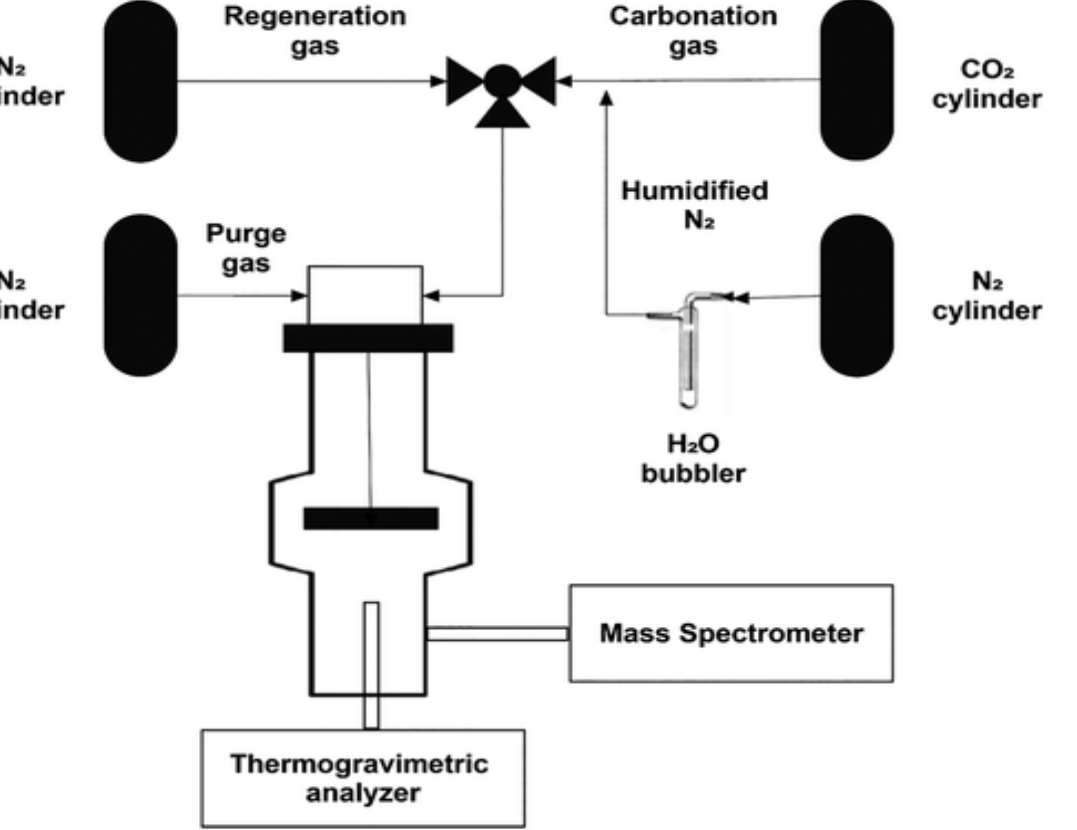
Figure 1. The schematic design of the experimental setup utilized for CO 2 collection is reprinted with permission from [27]. Table 1. The effect of the different operating parameters, i.e., carbonation temperature, carbonation time, and H 2 O to CO 2 ratio, on the CO 2 adsorption capacity, reproduced with permission from [27]. Run